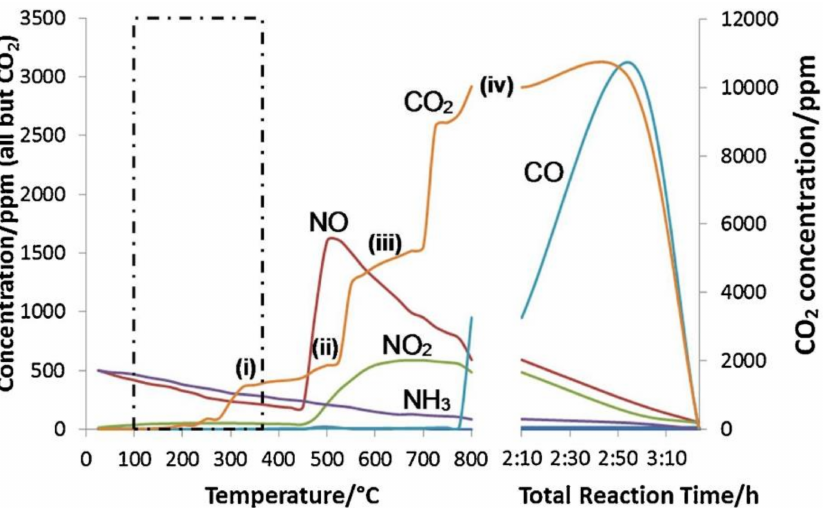
Figure 2. NOx reduction and soot oxidation when K-free Ag/CZA is mixed with carbon black. Dotted line indicates typical ‘temperature window’ for diesel exhaust emitted by passenger